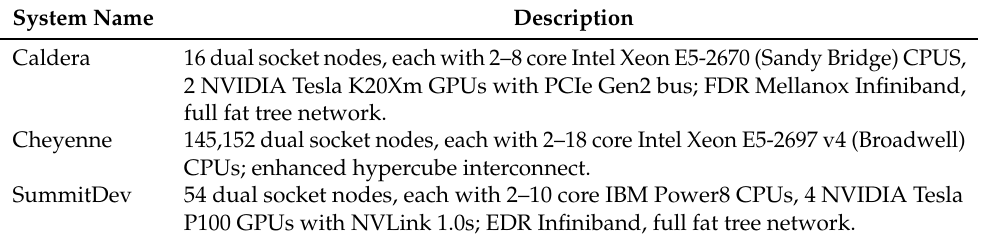
Table 2. Test system